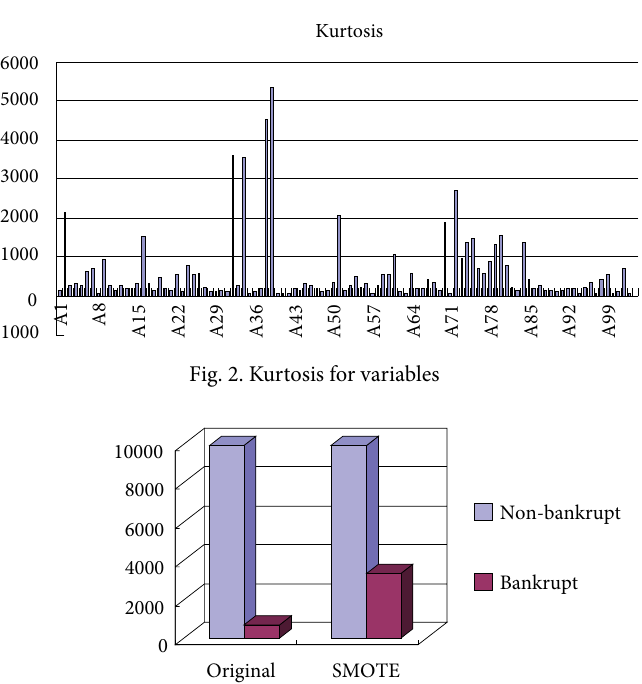
Fig. 3. Comparison of class sizes before and after applying